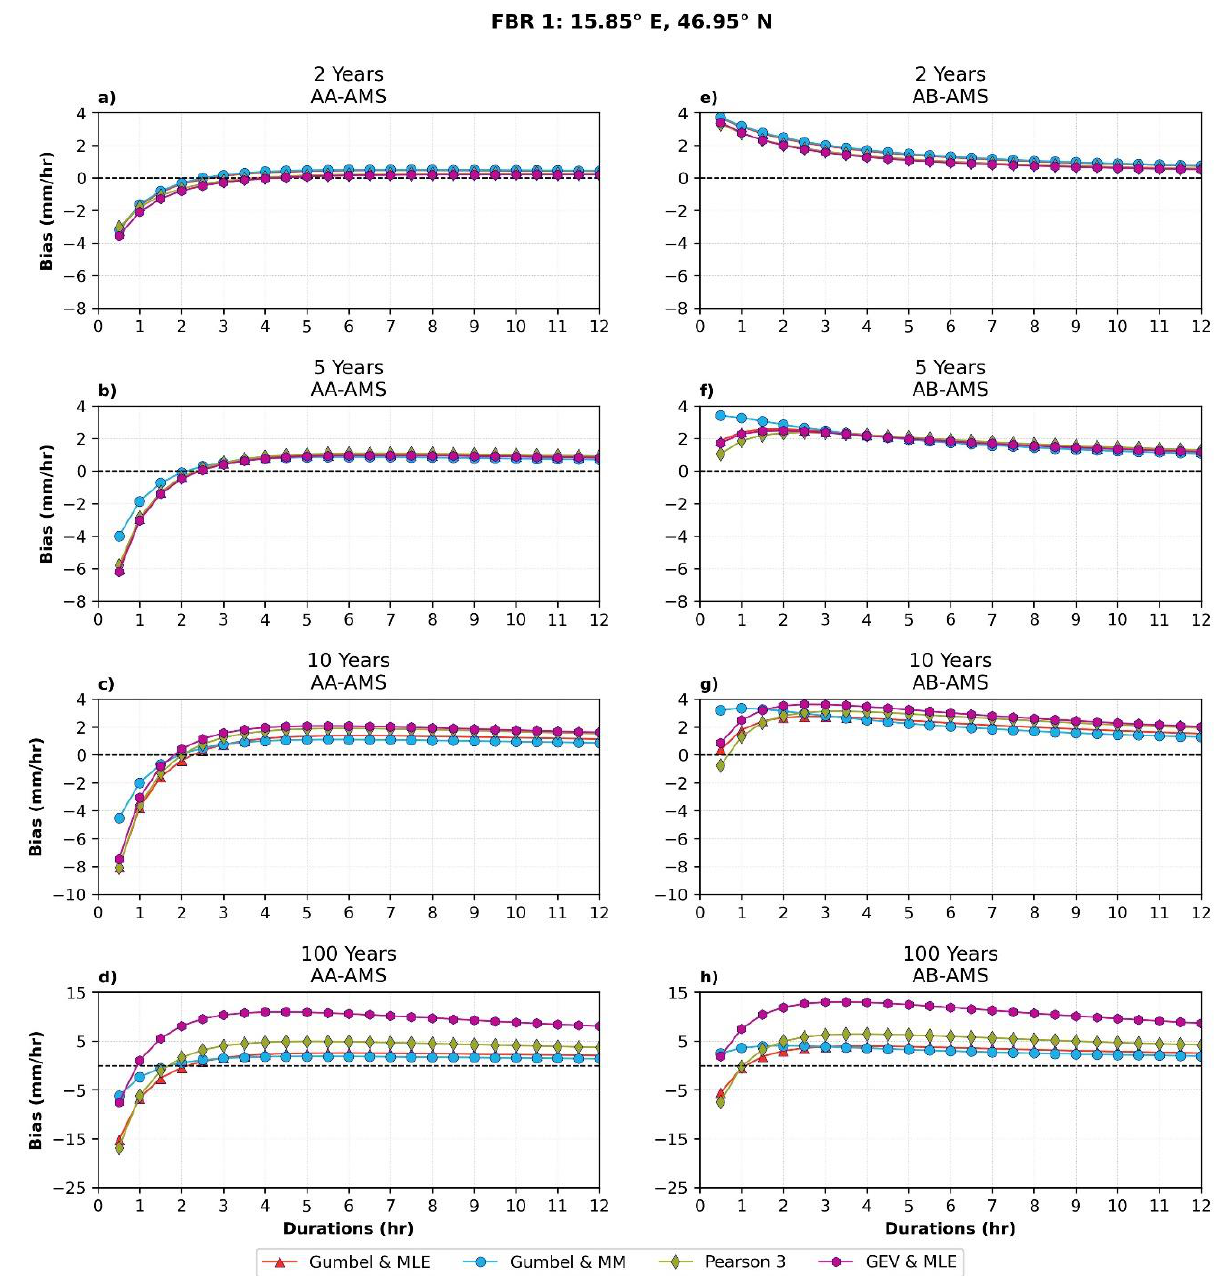
Figure A10. Precipitation intensity biases between IMERG IDFs and the gauge-based IDFs for 2, 5, 10, and 100 year return periods and event durations between 0.5 and 12 h over the FBR 1. IMERG IDF vs. AA-AMS IDF ( left ) and IMERG IDF vs. AB-AMS IDF ( right ).